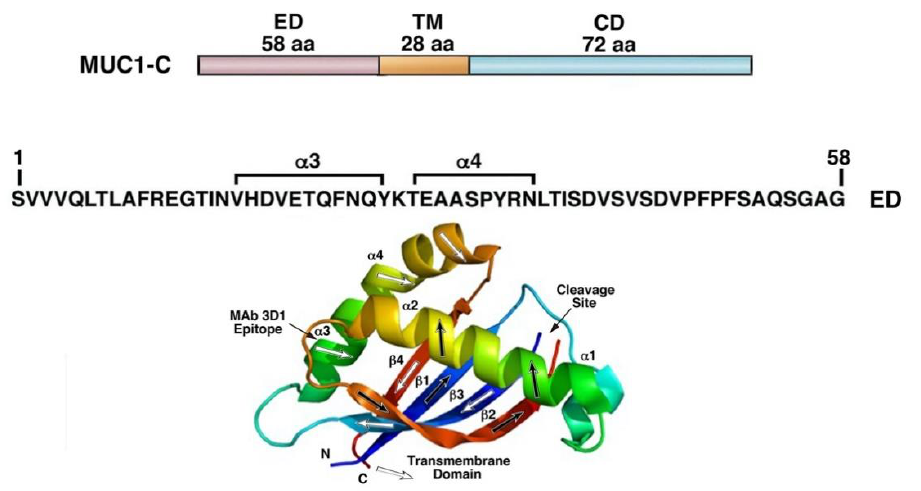
Figure 2. Targeting the MUC1-C extracellular domain. MUC1-C consists of a 58 aa extracellular domain (ED), 28 aa transmembrane domain (TM) and a 72 aa cytoplasmic domain (CD). The MUC1-